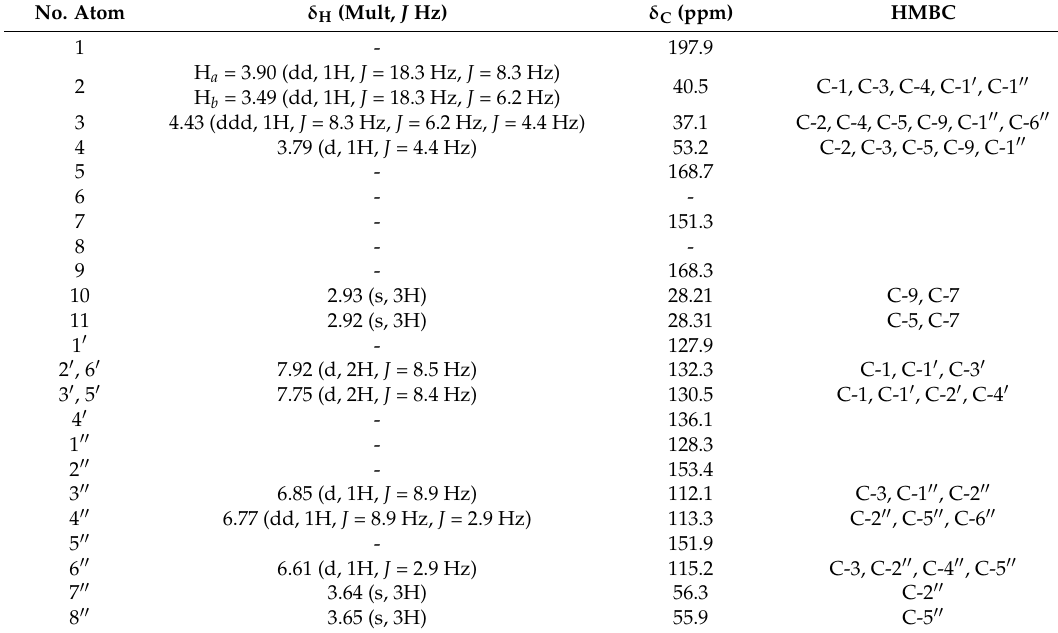
Table 1. NMR data of the target compound in DMSO- d 6